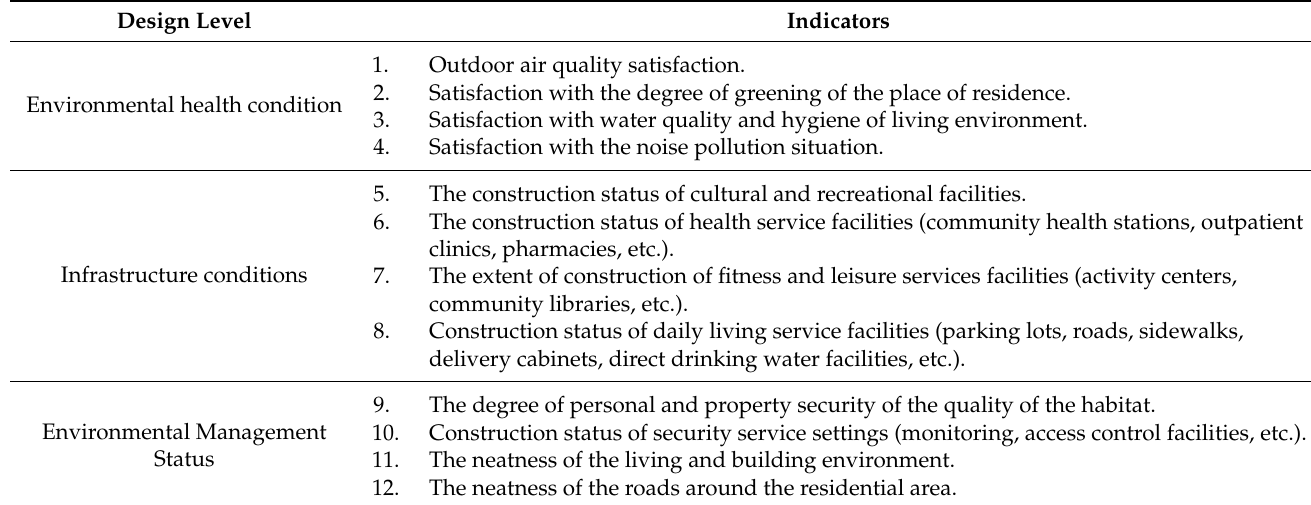
Table 2. Habitat quality evaluation